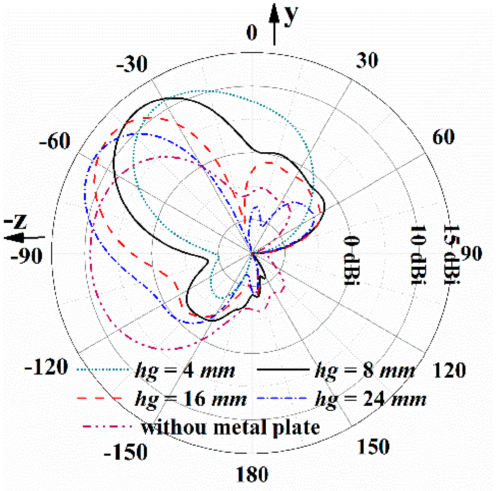
Figure 10. Radiation patterns of the proposed antenna with metal plate at 6.4 GHz as h g varies.